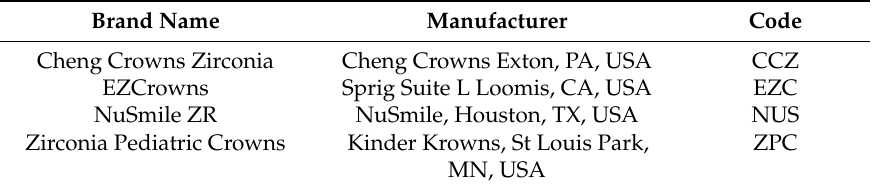
Table 1. Brand name, manufacturer, and code of all materials tested (n =